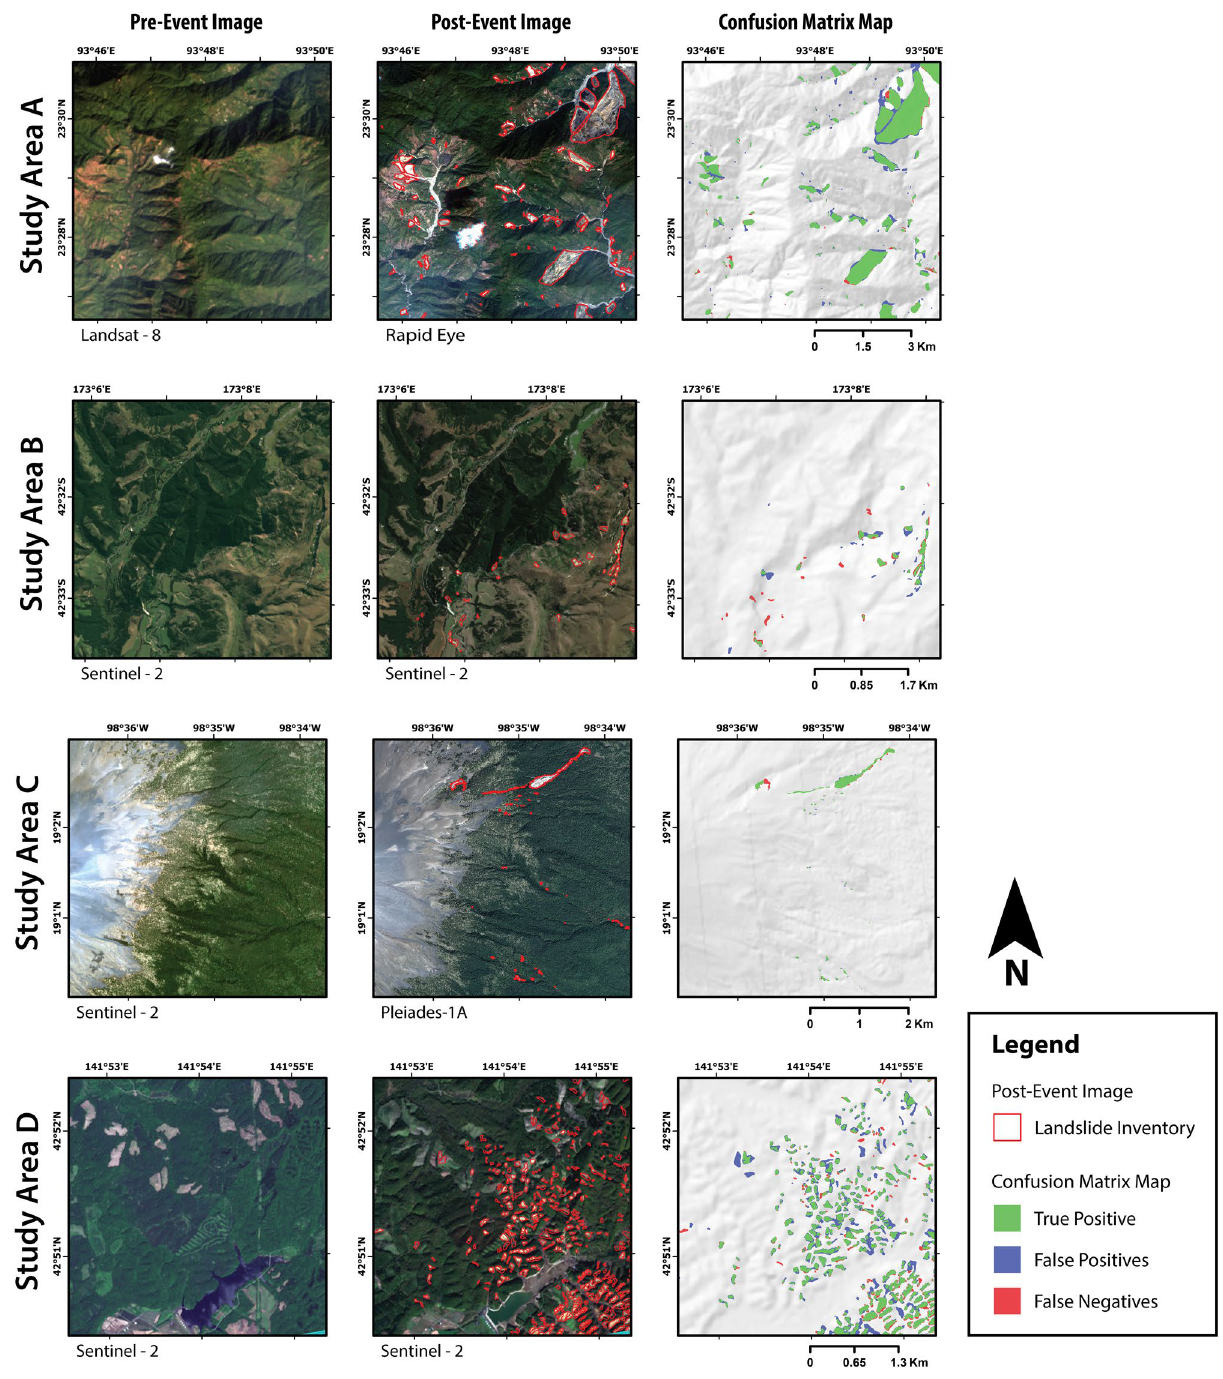
ALL Figure 3. Result of applying the trained CNN model ( M 6 ) on the testing region of study area “A” to “D”. Every row shows a fixed view from one study area with pre-event image (left), post-event image with polygons from landslide inventory (middle), and output from CNN as a confusion matrix map (right). The majority resampling method was used to visualize the confusion matrix map. The cloud and snow-cover masks have not been shown for clarity, but the affected region was not used in the training and prediction process. The maps were created using ArcGIS Pro v2.4 (https:// www. esri.